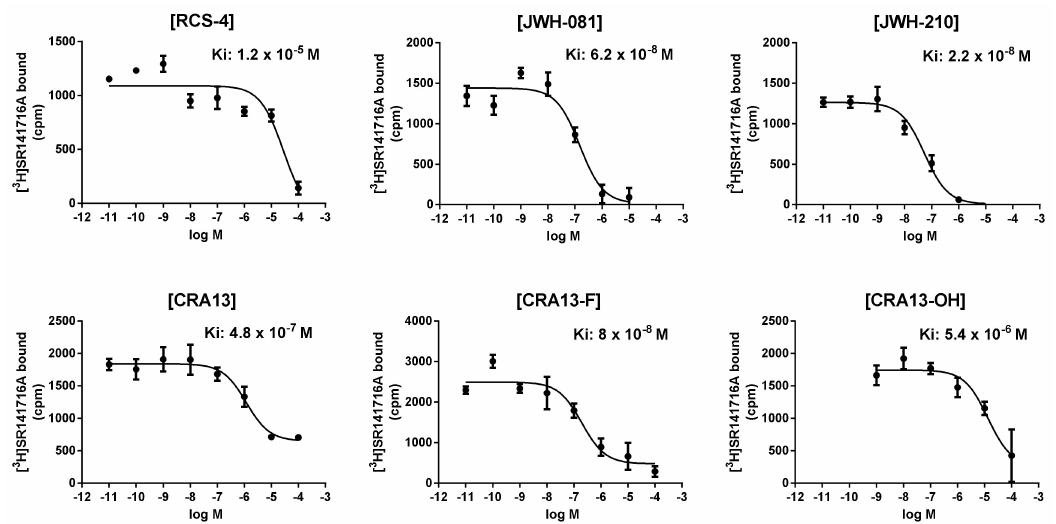
Figure 3. Cannabinoid receptor 1-binding a ffi nities of THC and synthetic cannabinoids.